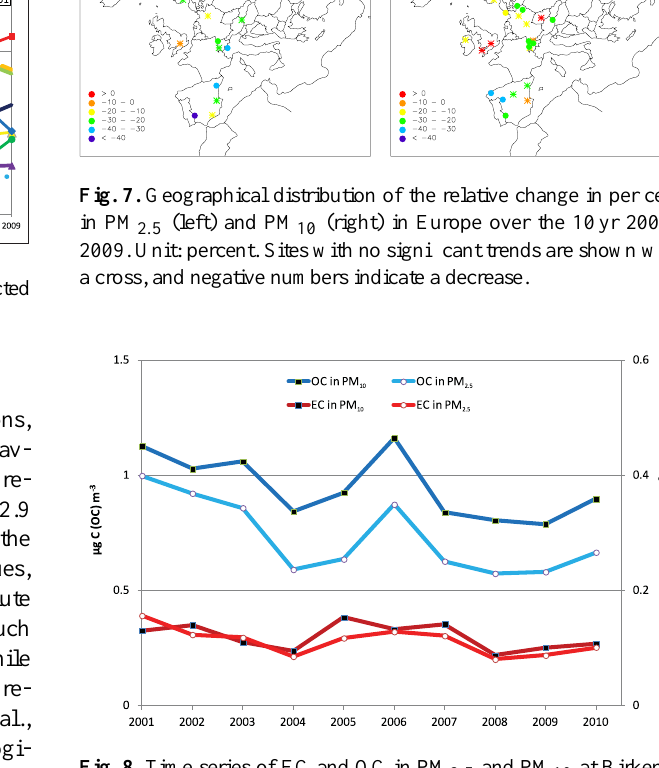
Fig. 8. Time series of EC and OC in PM 2 . 5 and PM 10 at Birkenes (NO01), Southern